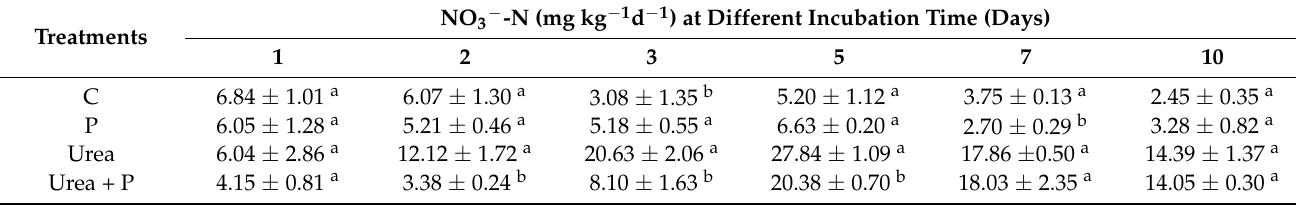
Table 1. Net nitrification rate in soil amended with Urea, P, Urea + P and the control during 10 days of incubation.